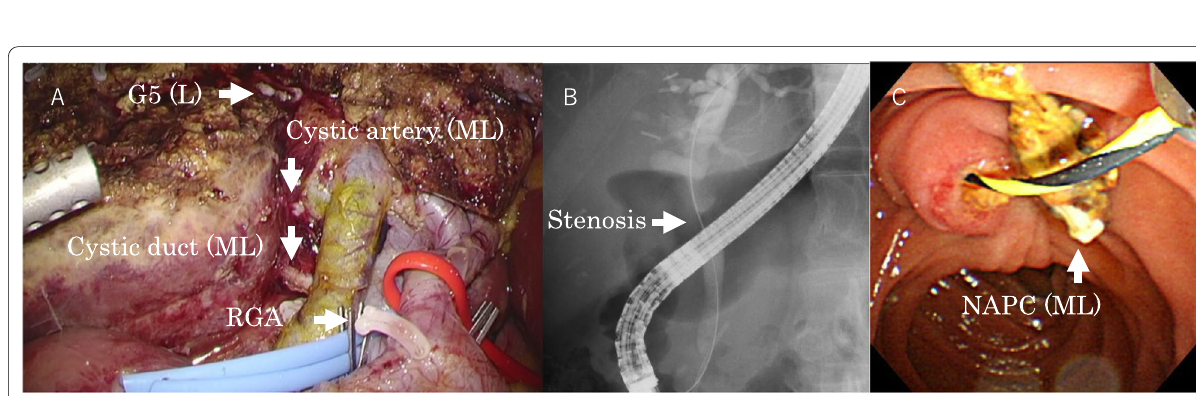
Fig. 5 Intraoperative and postoperative findings for case 3. A Laparoscopic S4b/S5 resection and lymph node dissection were performed. Medium-large NAPCs were placed at the cut surface of the liver, the cystic artery, the cystic duct, and the right gastric artery. Large NAPCs were placed at the Glissonean pedicle of segment 5. B ERCP and endoscopic biliary drainage were performed. C A medium-large NAPC was found when the endoscopic biliary drainage tube was